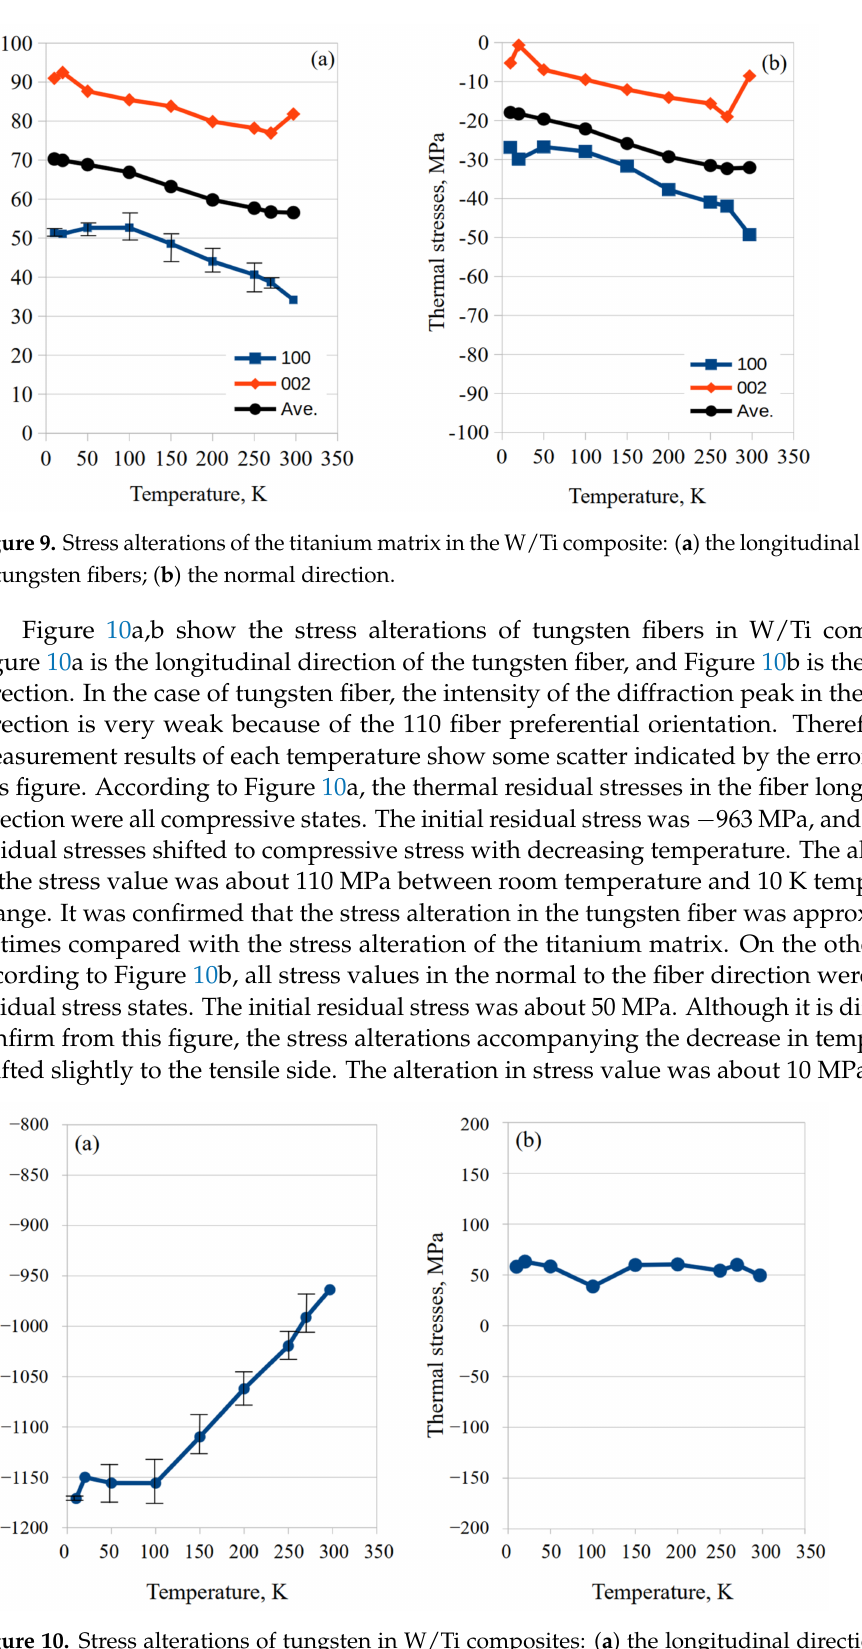
Figure 10. Stress alterations of tungsten in W/Ti composites: ( a ) the longitudinal direction of the tungsten fiber; ( b ) the normal